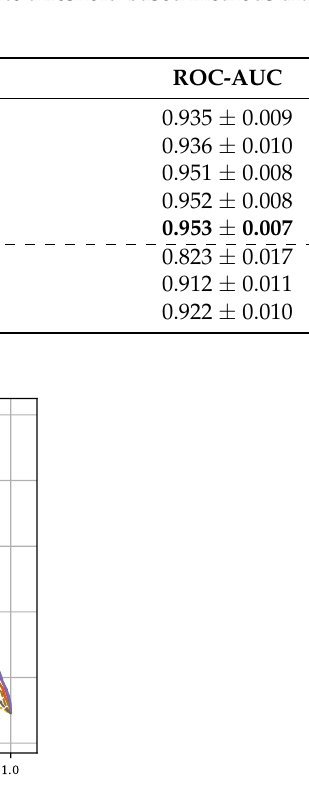
Figure 11. Precision–recall curve based on 5-fold cross-validation. Dashed lines indicate the results obtained from univariate threshold-based methods that, in this study, we considered as benchmarks.